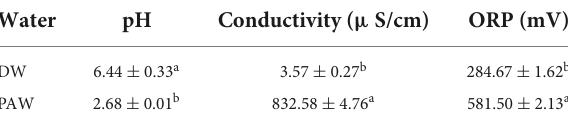
TABLE 1 Physicochemical properties of DW and PAW.